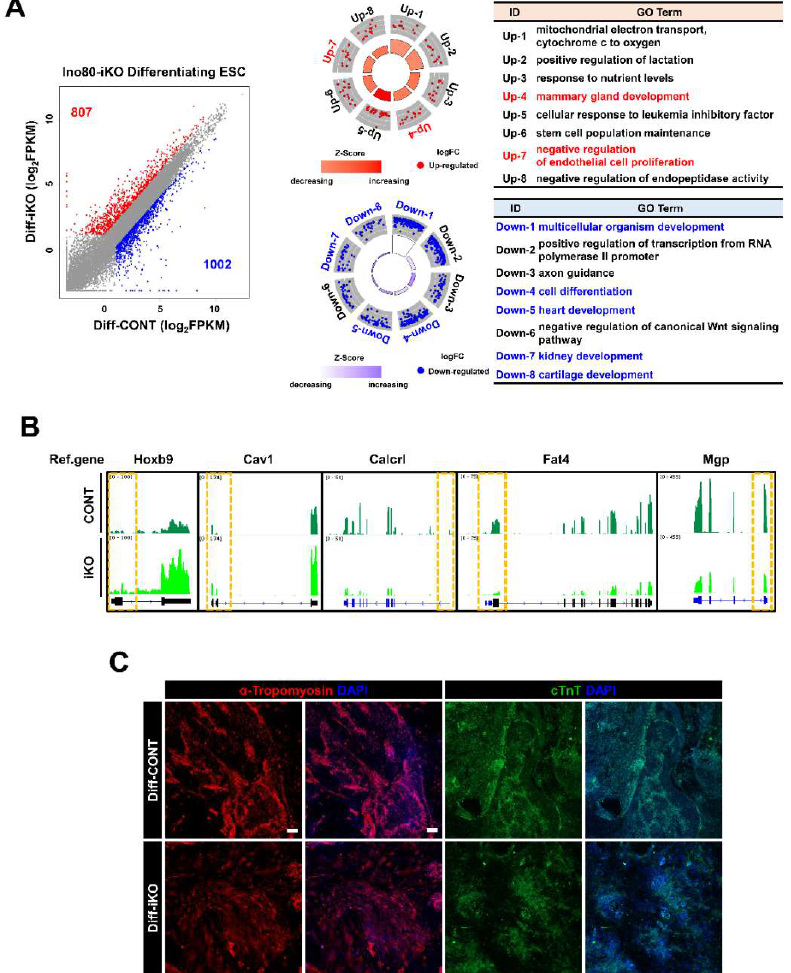
Figure 4. RNA-seq analysis revealed aberrant expression of genes important for organ development in Diff–iKO ESCs. ( A ) Scatter plot showing DEGs in Diff–iKO ESCs, and GO term analysis. Total 1809 DEGs (Cut-off value, FC ≥ 2, FPKM ≥ 2); 807 up-regulated genes and 1002 down-regulated gene were detected. GO terms associated with differentiation are highlighted with red or blue fonts. ( B ) Visualization of representative DEGs (Hoxb9, Cav1, Calcrl, Fat4, and Mgp) related to mesodermal differentiation GO terms in Diff–iKO ESCs using IGV. Yellow dotted line indicates TSS of the corresponding genes. ( C ) Immunofluorescence of cardiac muscle marker (cTnT and alpha-Tropomyosin) in Diff–CONT and Diff–iKO ESCs. Scale bar, 200 µ